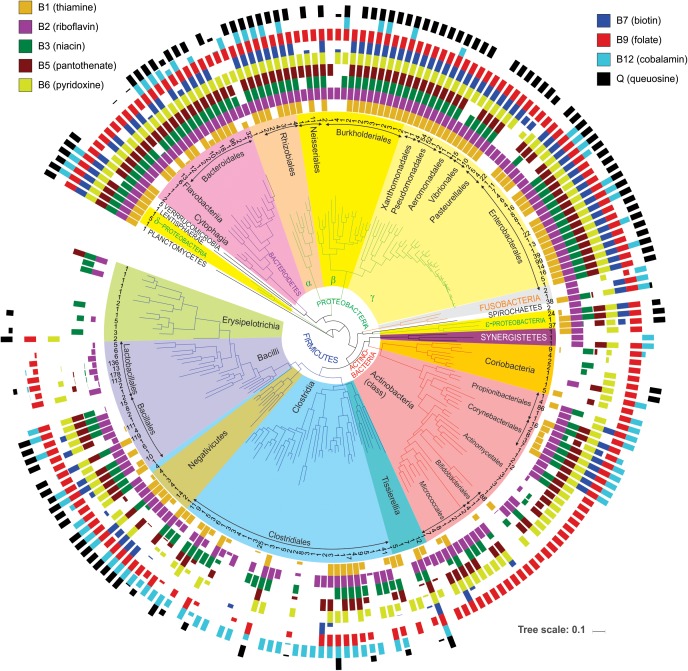
Distribution of vitamin producers among analyzed HGM strains. The phylogenetic tree of HGM genera was obtained from the larger tree constructed by RAxML based on concatenated sequences of ribosomal proteins from the analyzed HGM species. Number of analyzed strains per genus is shown in the inner circle; higher-level taxonomic groups such as orders, classes, and phyla are highlighted inside the tree. Colored bars show average vitamin production phenotypes (prototrophy) of each genus. Empty bars correspond to auxotrophic phenotypes.